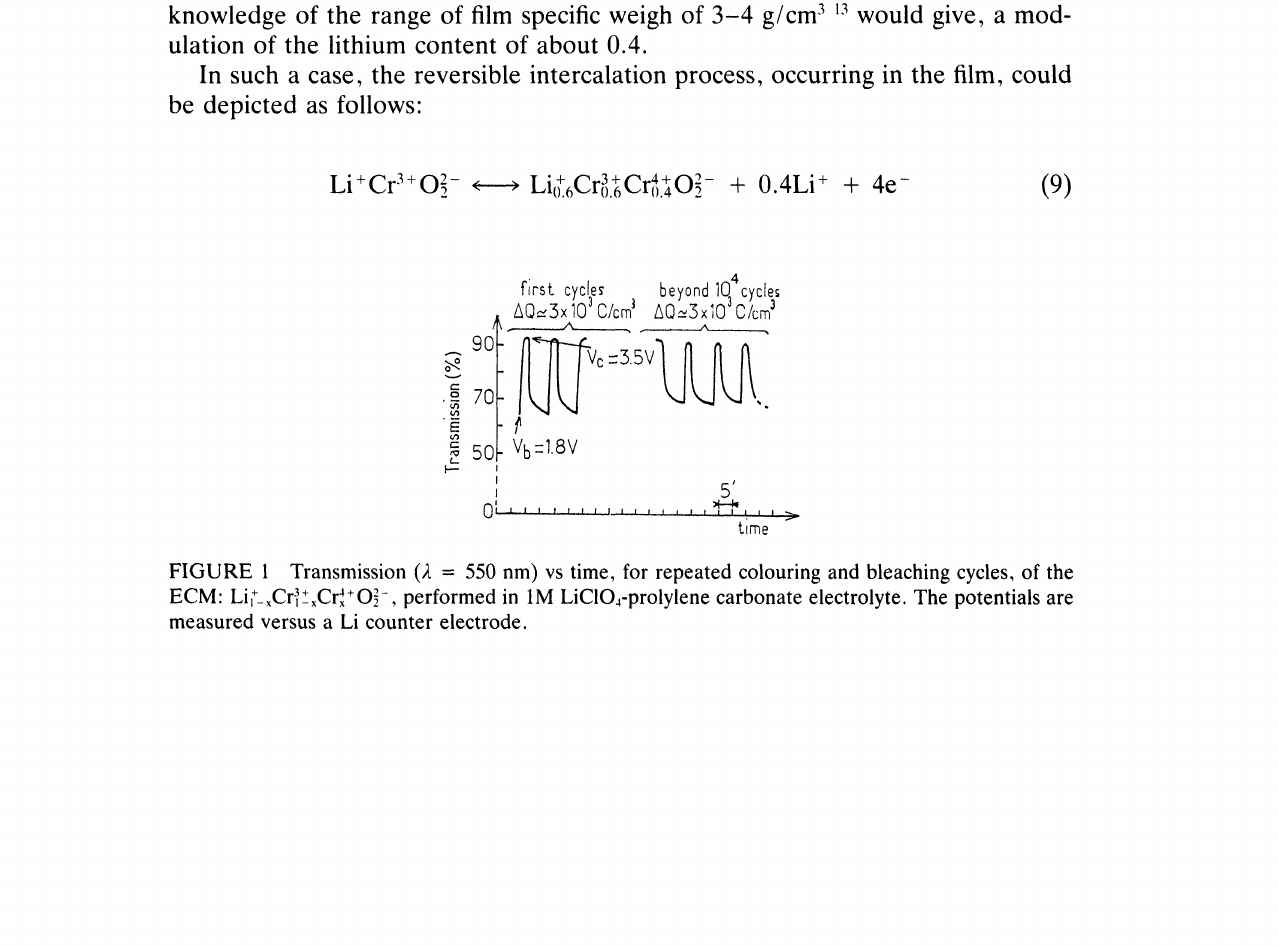
Transmission (2 550 nm) vs time, for repeated colouring and bleaching cycles, of the ECM: Lil +- x-’l(’’3 x’-"x(’%’4+ O- performed in 1M LiCIO4-prolylene carbonate electrolyte. The potentials are measured versus a Li counter